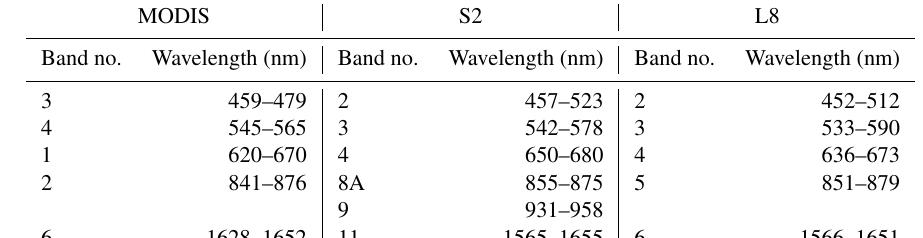
Table 3. MODIS, S2, and L8 bands used in SIAC for the atmospheric parameters retrieval.